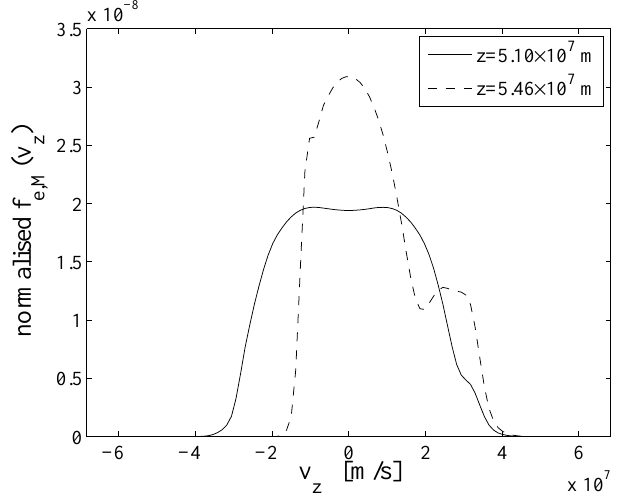
Fig. 9. Distribution function f (v z ) of the electrons of magneto- spheric origin for z = 5 . 10 × 10 7 m (solid line) and z = 5 . 46 × 10 7 m (dashed line). In both cases t = 5s. The distribution functions have been normalised so that R f (v z )dv z =